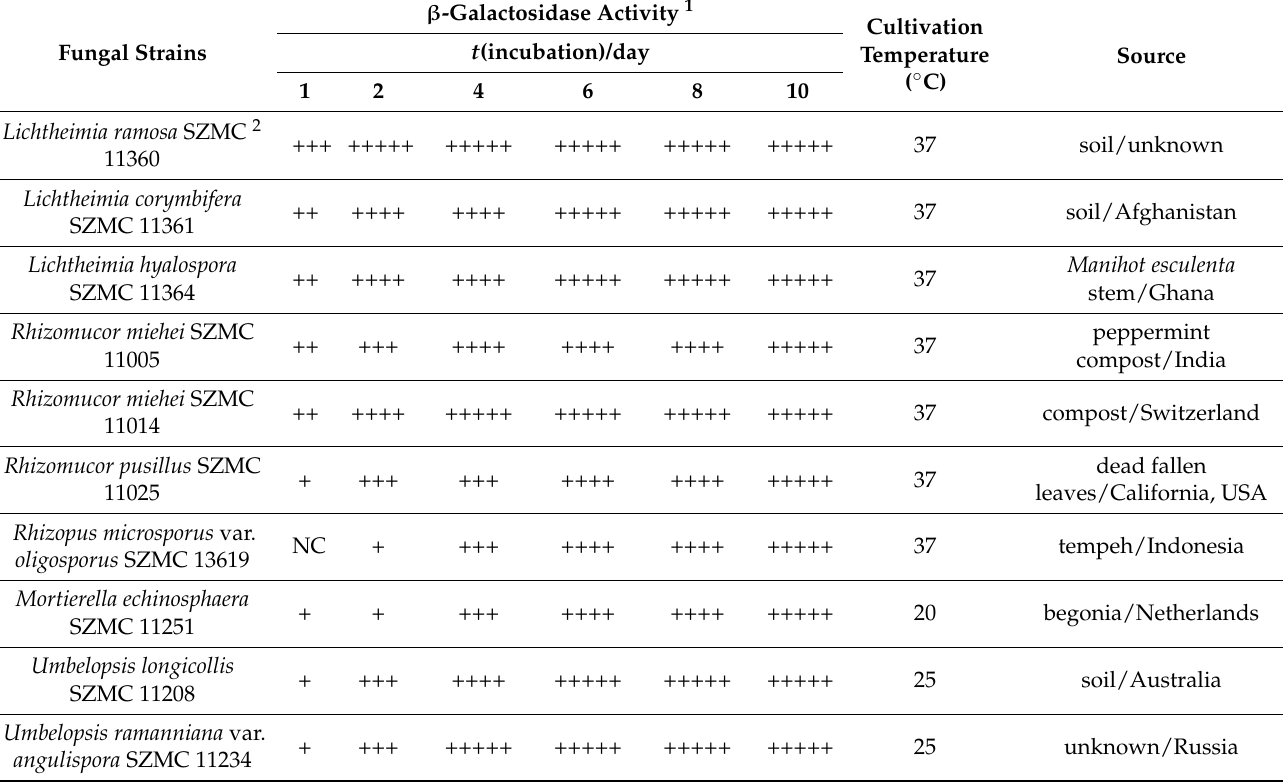
Cultivation Temperature Source t (incubation)/day ( ◦ C)